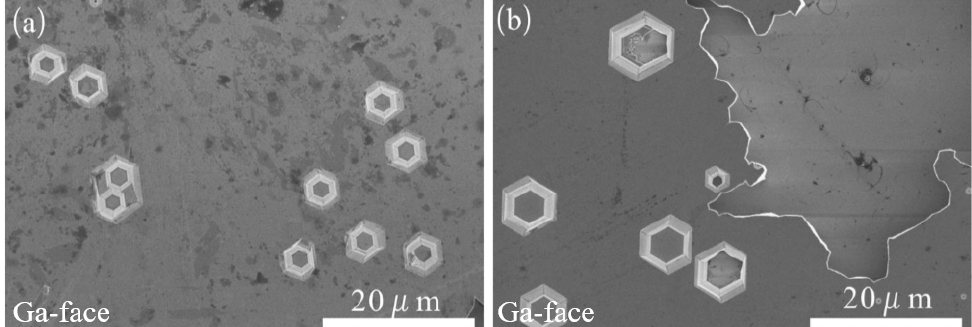
Figure 1. SEM images of the etched metal–organic chemical vapor deposition (MOCVD) grown GaN surface in H 3 PO 4 at 230 ◦ C for ( a ) 10 min and ( b ) 14 min.